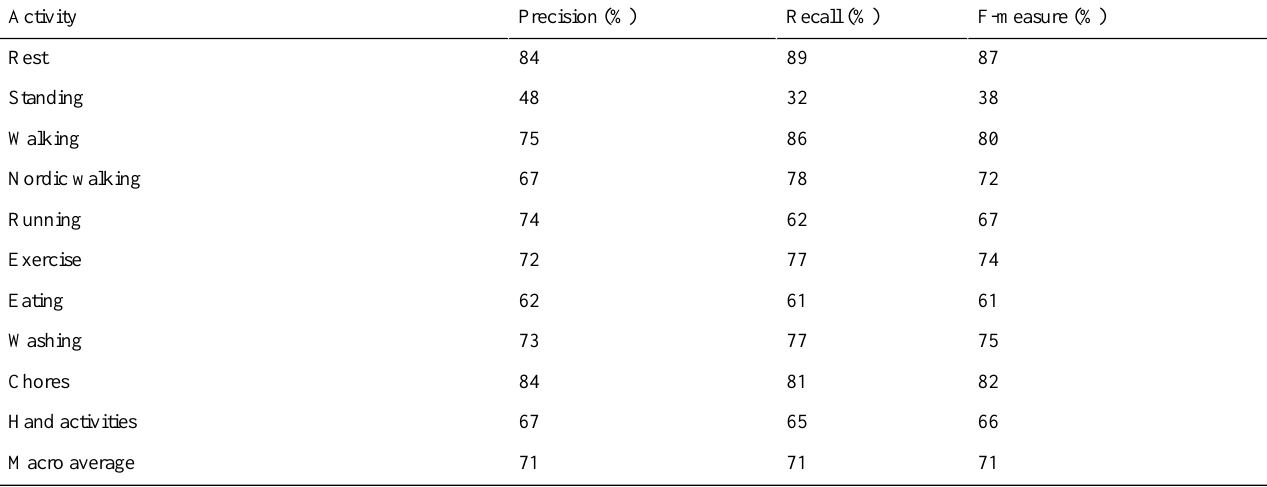
Table 5. Precision, recall, and F-measure of the physical activity